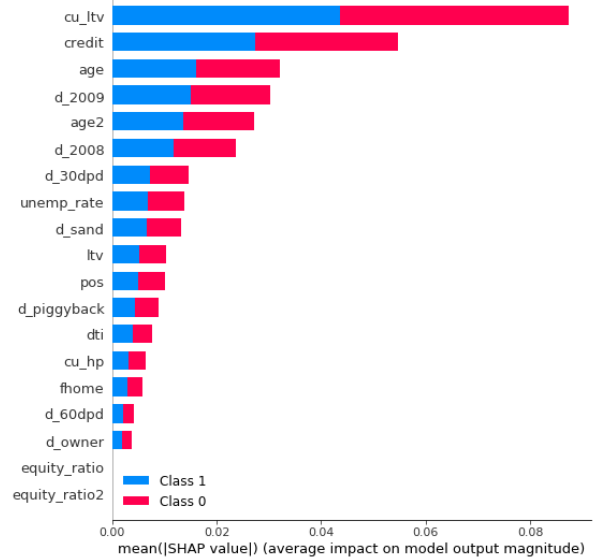
Note: Class 1 indicates the default classification. Figure 4. SHAP value results for the ANN